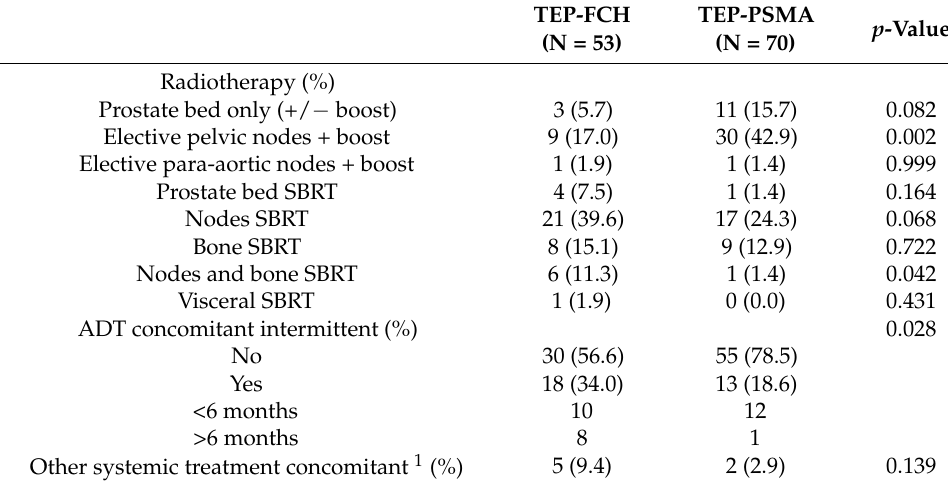
Table 3. Treatment characteristics guided by PET/CT